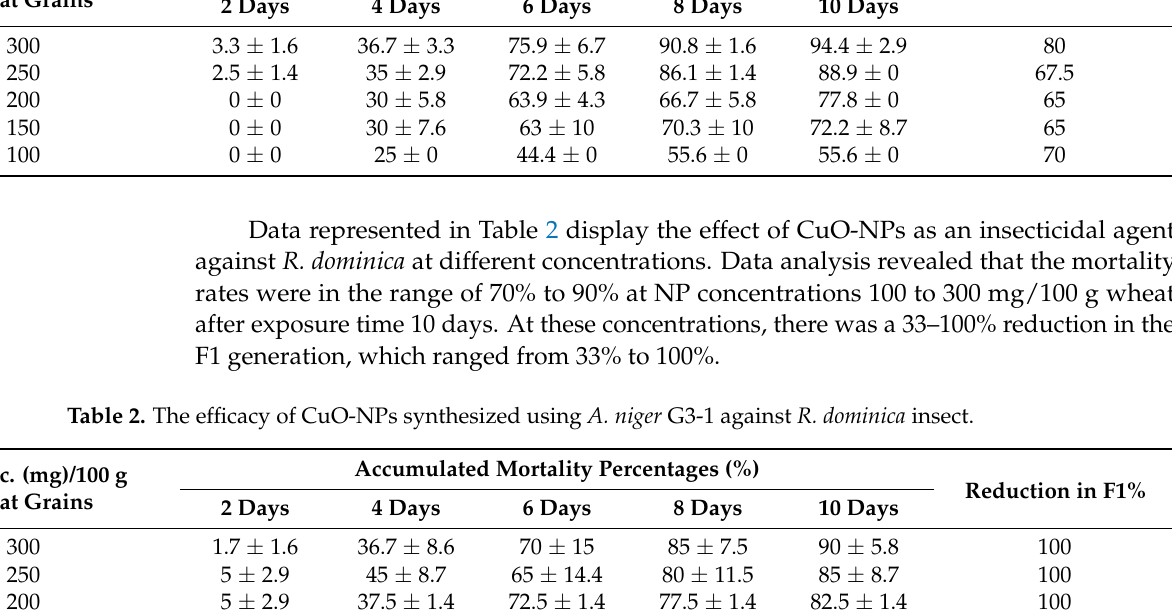
Table 1. The efficacy of CuO-NPs synthesized using A. niger G3-1 against S. granaries insect. Accumulated Mortality Percentages (%) NP Conc. (mg)/100 g Wheat Grains 2 Days